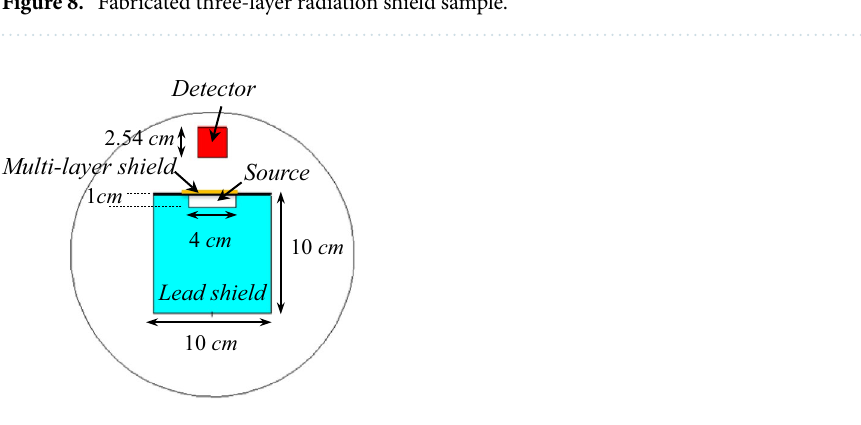
Figure 8. Fabricated three-layer radiation shield sample.